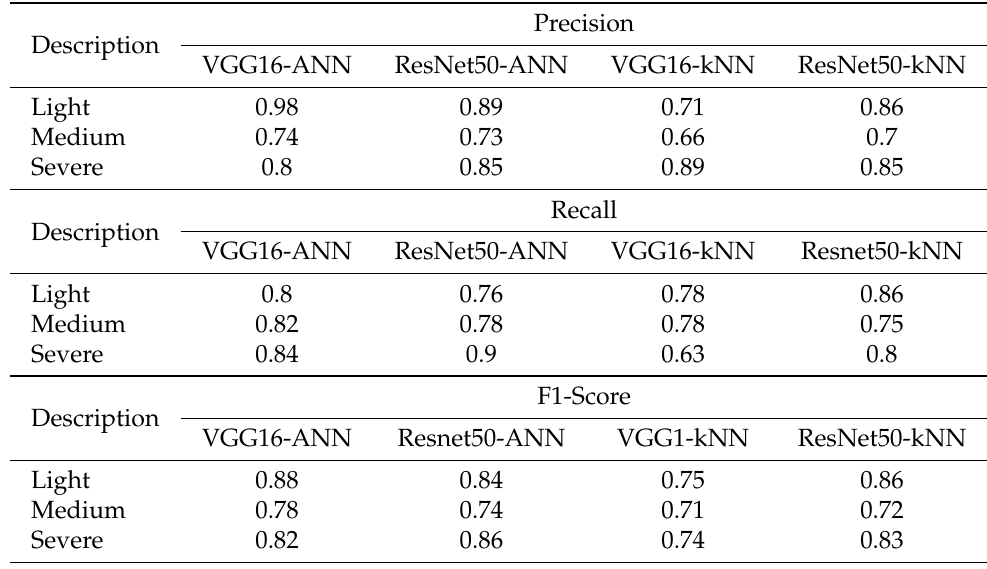
Figure 11. Comparison of confusion matrix for trained ( a ) VGG16-ANN, ( b ) ResNet50-ANN, ( c ) VGG16-kNN, and ( d ) ResNet50-kNN in the RGB dataset. Table 3. Classification performance of four models in test 1 using RGB